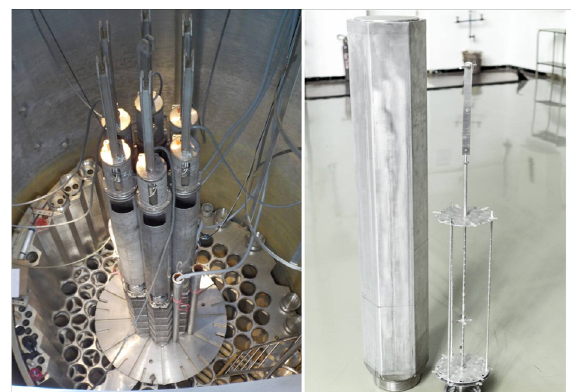
Figure 1. Overhead view inside the LR-0 reactor with a spe- cial core without moderator (left) and a dry experimental channel with activation foil holder (right).